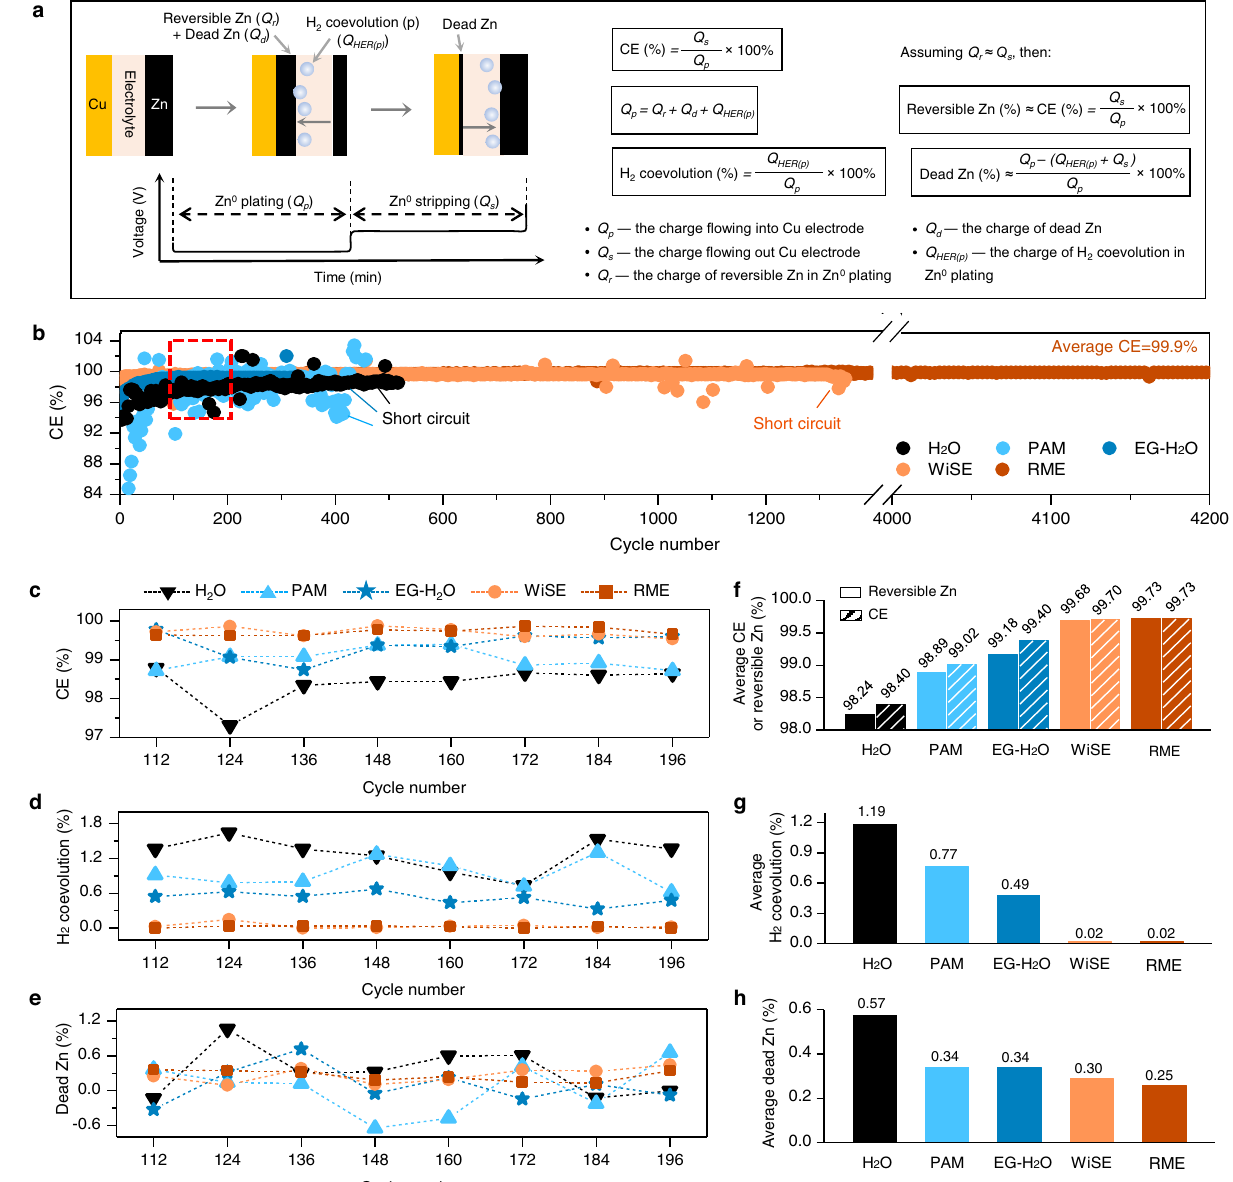
Fig. 3 | Modi fi ed CE protocol to evaluate the plating/stripping reversibility of Zn 0 anode in the H 2 O electrolyte,the EG-H 2 O electrolyte,the PAM electrolyte, the WiSE, and the RME in extended cycles. a Schematic illustration of the mod- i fi edCE protocol. b CE of Zn(50 µ m)||Cu asymmetriccellinthe fi ve electrolytes. CE ( c ),contributionofH 2 coevolution( d ),andcontributionofdeadZn( e )asafunction